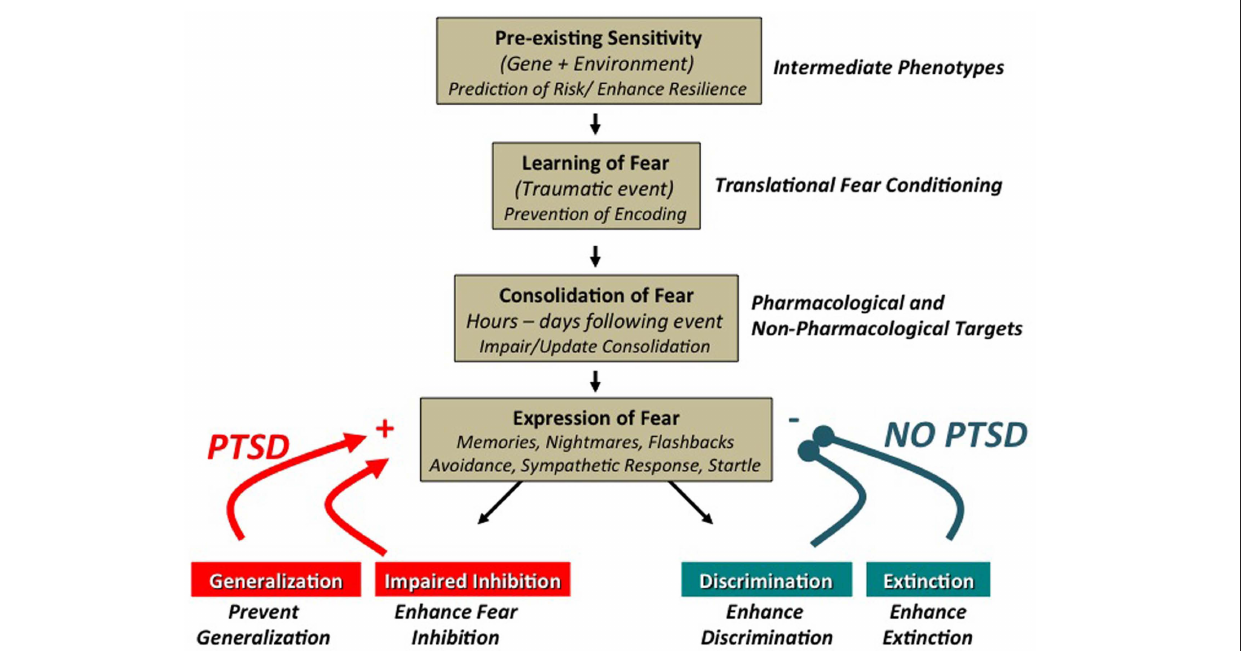
FiGure 1 | Promising targets for the translational study of trauma-, stressor-, and anxiety-related fear behaviors: trauma-, stressor-, and anxiety-related disorders have been shown to have a significant degree of heritability and more recently, it has become increasingly clear that genetic contributions include complex gene × environment interactions. Understanding these complex relationships may allow for early interventions to enhance resiliency in certain individuals with a high risk of trauma. Fear-conditioning paradigms afford the study of intermediate phenotypes, which may enhance our ability to elucidate these complex interactions [see Ref. (36)]. The dysregulated fear learning commonly observed in anxious and traumatized populations can be modeled by fear-conditioning paradigms, which can provide a translational framework. Translational studies have shown that